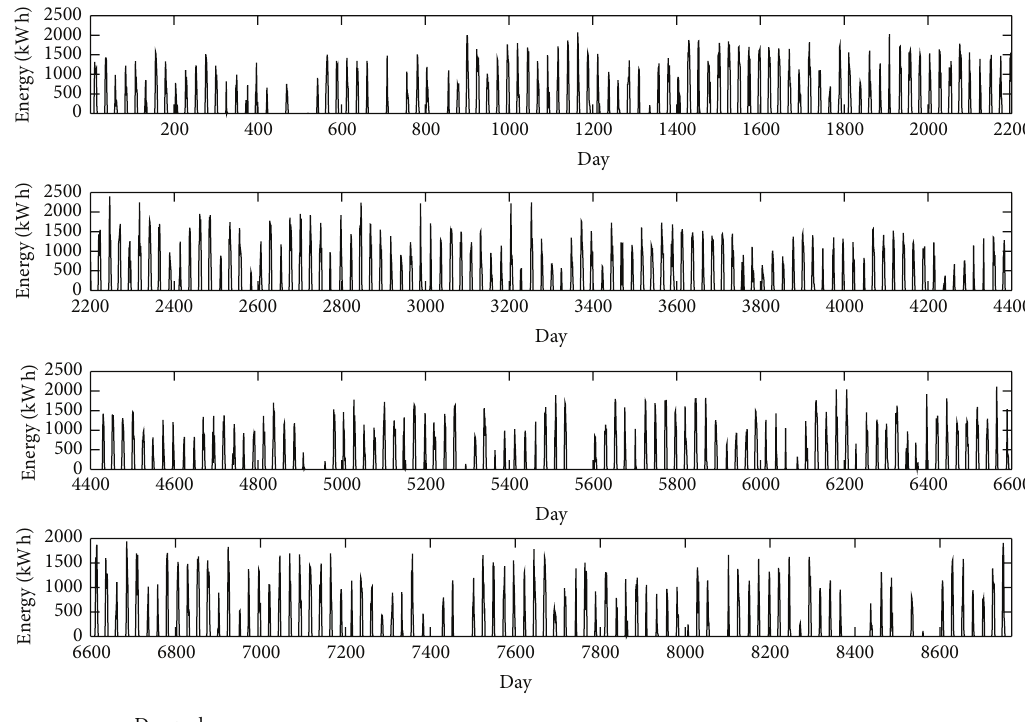
Figure 7: Dumped power for the designed PV